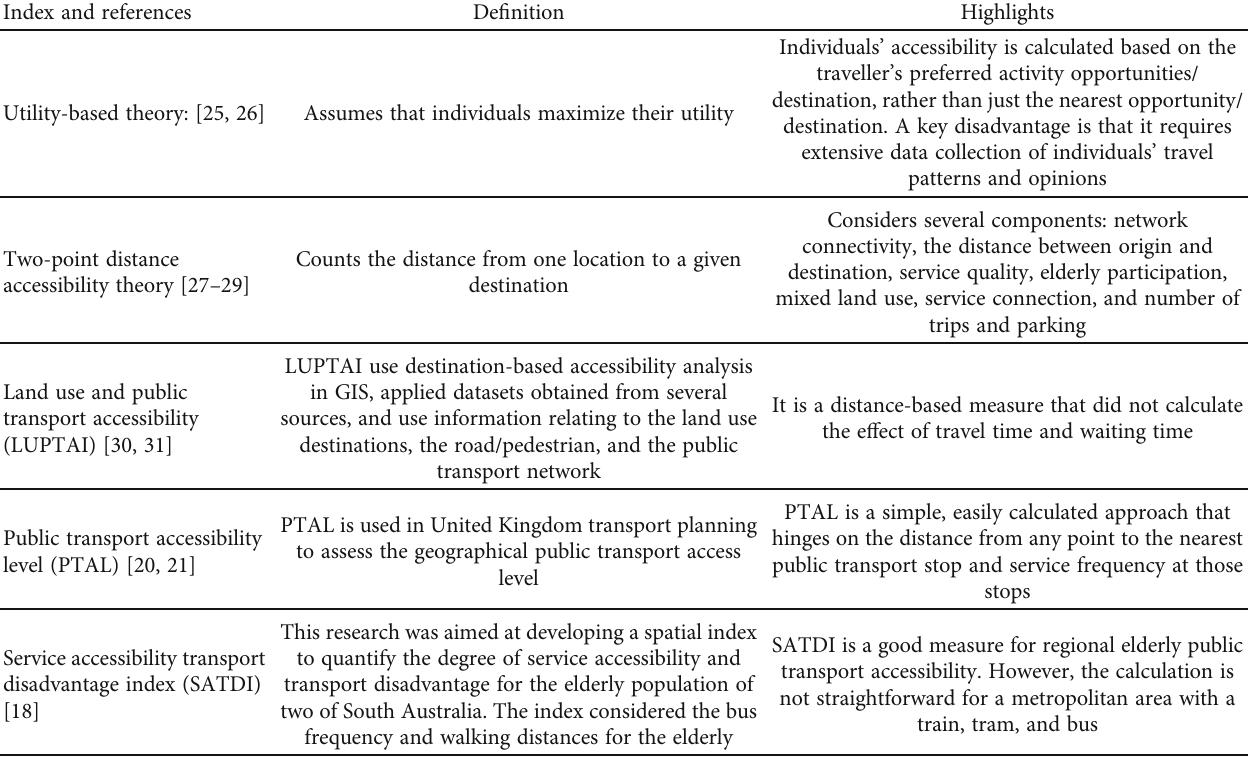
Table 1: Distance-based PT accessibility index study.